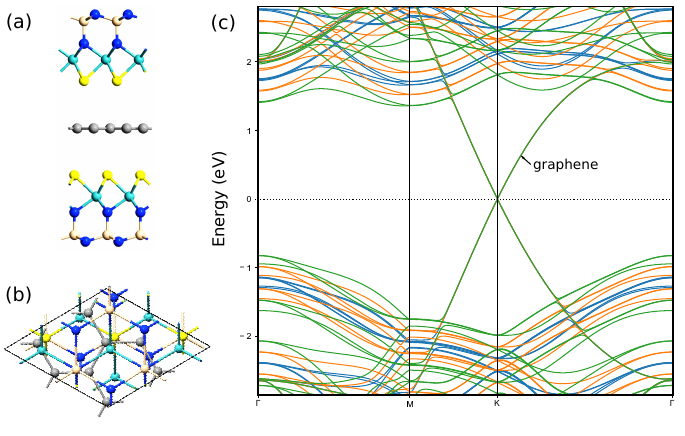
Figure 11. Geometry of three-layer vdW heterostructure S-MoSiN 2 /graphene/S-MoSiN 2 ( a , b ). Bandstructures ( c ) are calculated for three values of electric field: 0 V/nm (blue line), 0.667 V/nm (orange line), and 1.333 V/nm (green